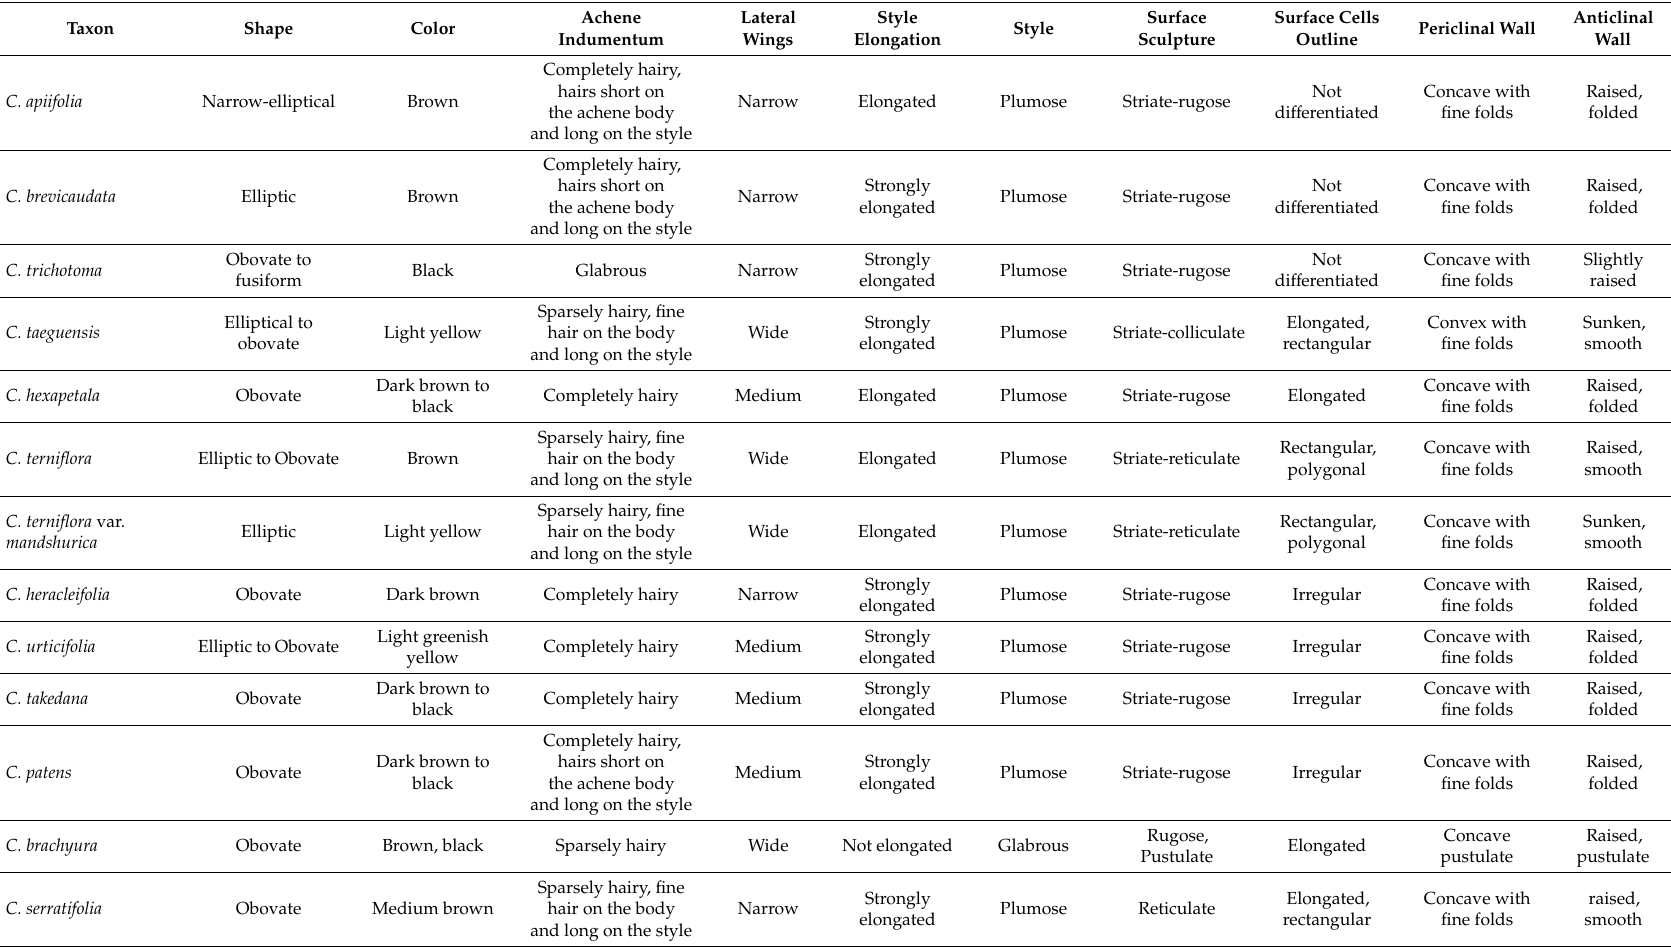
Table 2. Morphological and anatomical features of achene of